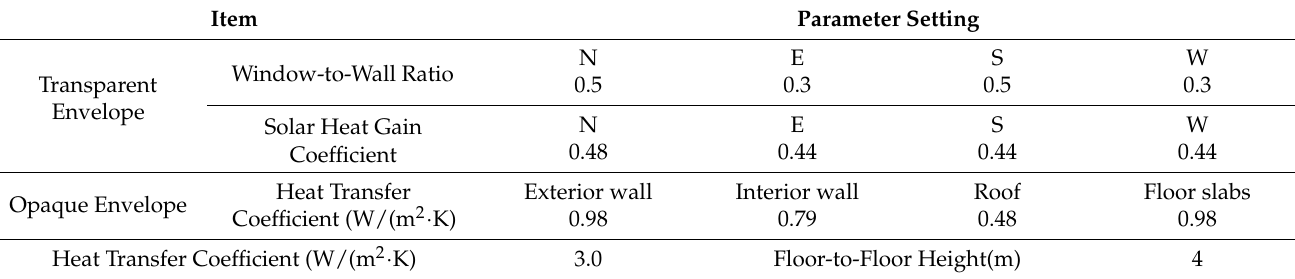
Table 3. Parameter setting in the BES